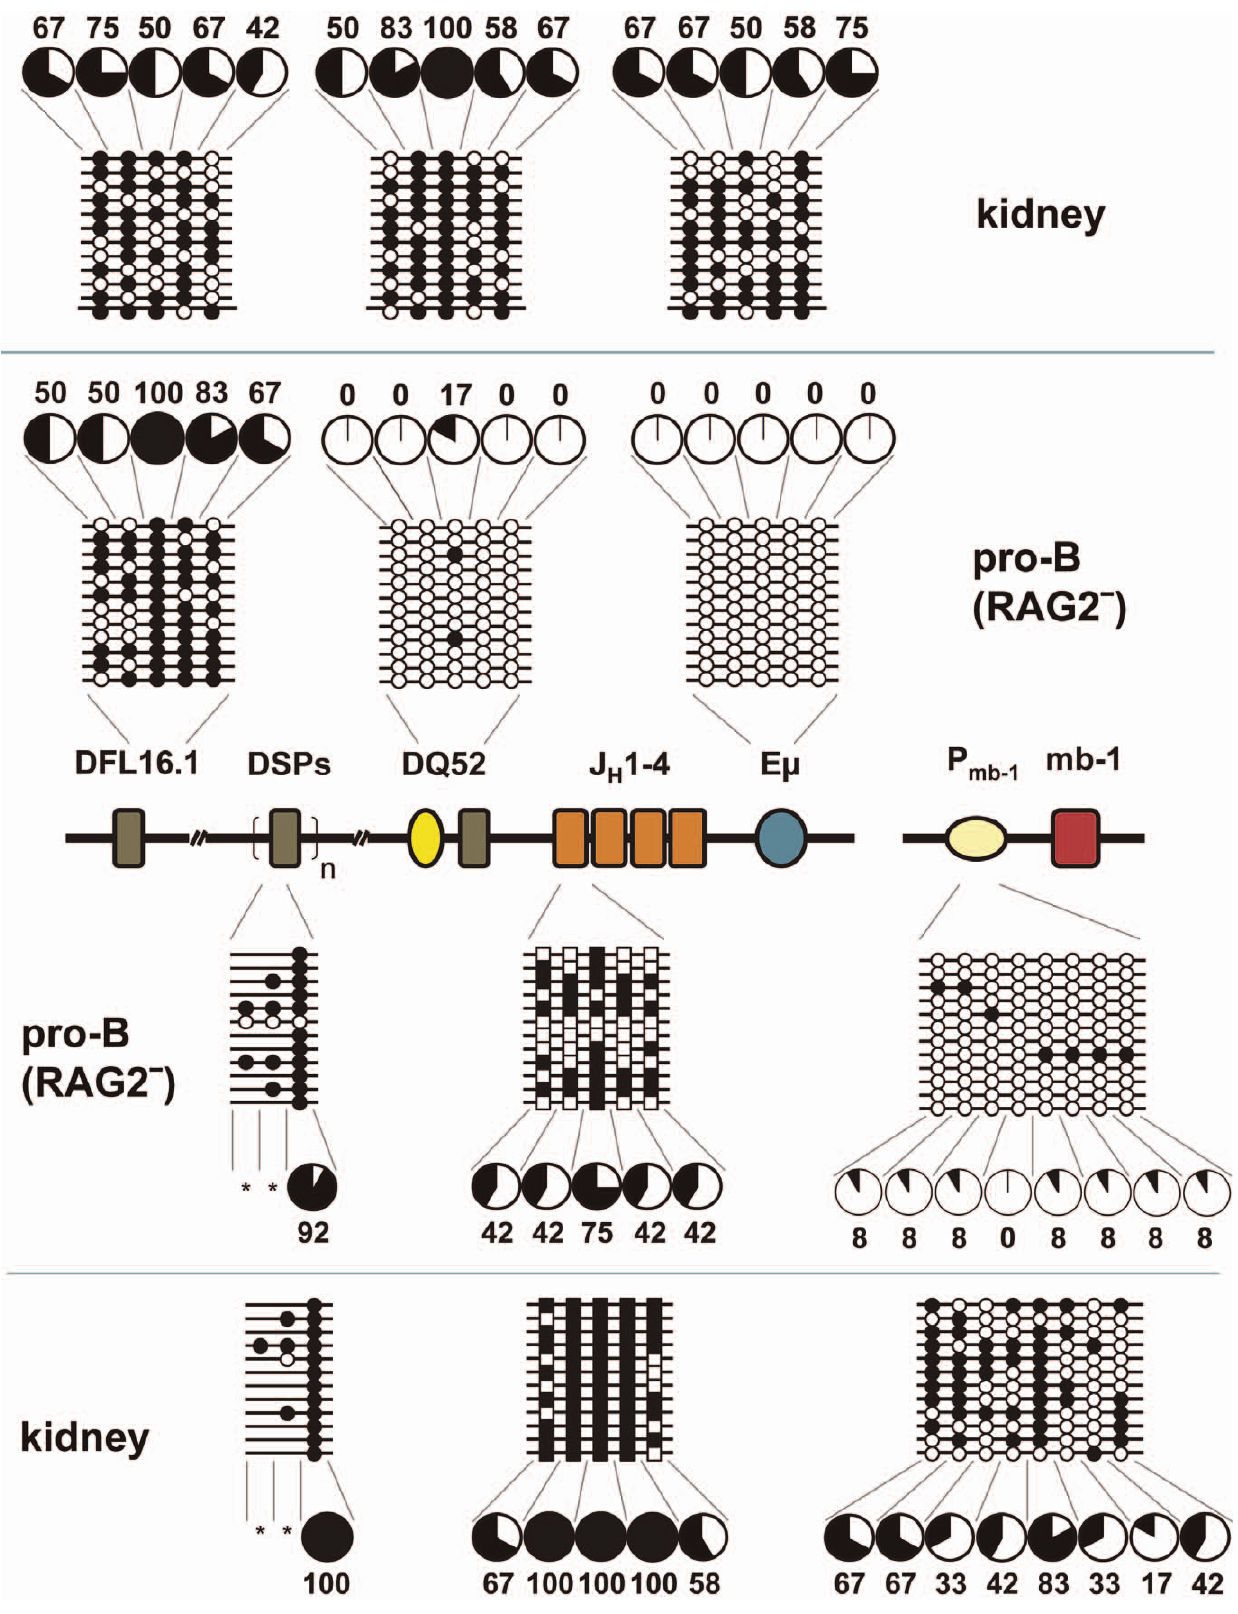
Figure 2. DNA methylation in the D H -C m domain of the IgH locus. Purified genomic DNA from CD19 + pro-B cells obtained from the bone marrow of RAG2-deficient mice was used in bisulfite modification assays. 400–500-bp amplicons corresponding to D H and J H gene segments and regulatory sequences (DQ52 and E m ) as indicated were cloned and sequenced. Each horizontal line represents the methylation status of a sequenced